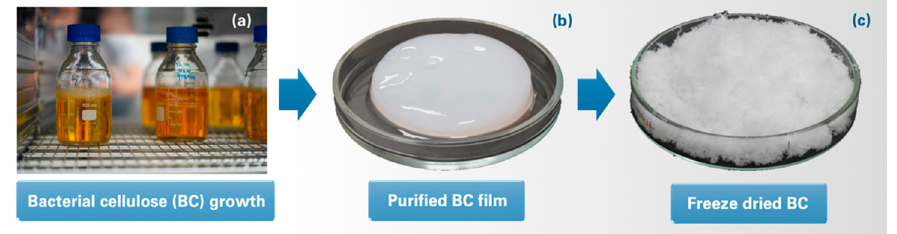
Figure 1. BC growing ( a ) a purified BC hydrogel ( b ) and BC after shredding and freeze drying ( c ).